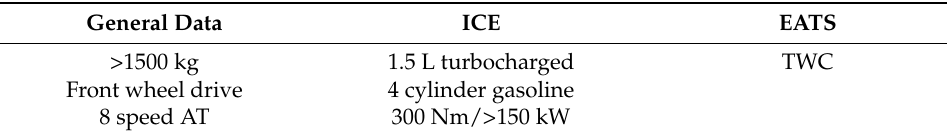
Figure 14. HiL test bench setup for virtual calibration. Table 2. Specification of simulated vehicle in the HiL